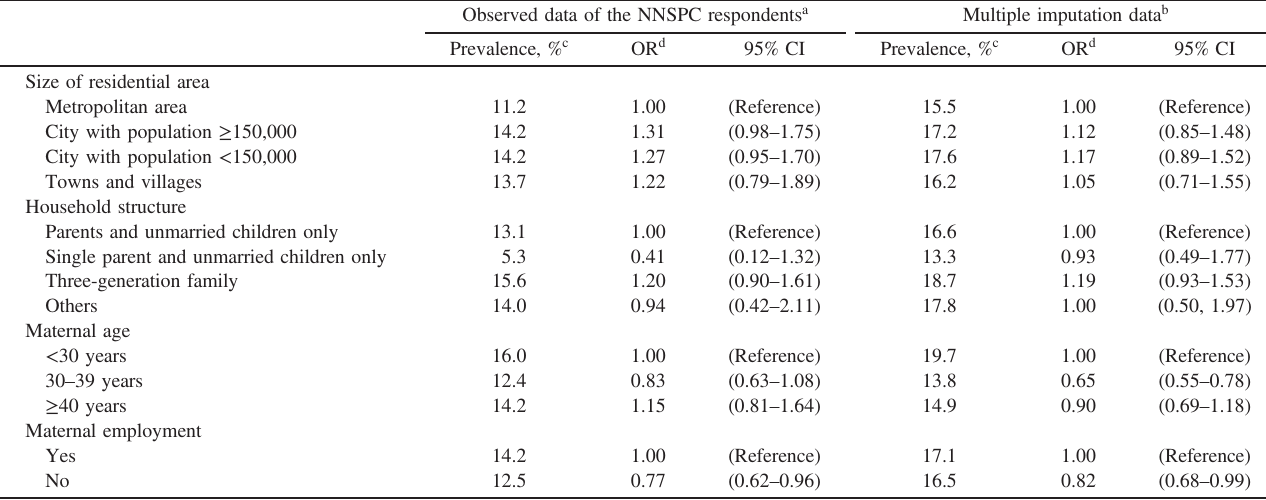
Table 4. Comparison of odds ratio of overweigh by sociodemographic characteristics estimated from observed and multiple imputation